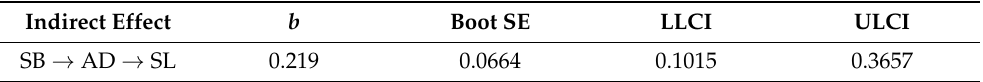
Table 5. Mediation effect of acceptance of disability between sense of belonging and satisfaction with life. Predictor b SE t LLCI (95%) ULCI (95%) Outcome = Acceptance of disability ( R 2 = 0.0992, p < 0.001) Self-efficacy 0.237 0.060 3.93 *** 0.1175 0.3558 Constant 1.81 0.253 7.17 *** 1.3119 0.3558 Outcome = Satisfaction with life ( R 2 = 0.556, p < 0.001) Self-efficacy 0.385 0.071 5.39 *** 0.2437 Acceptance 0.925 of disability